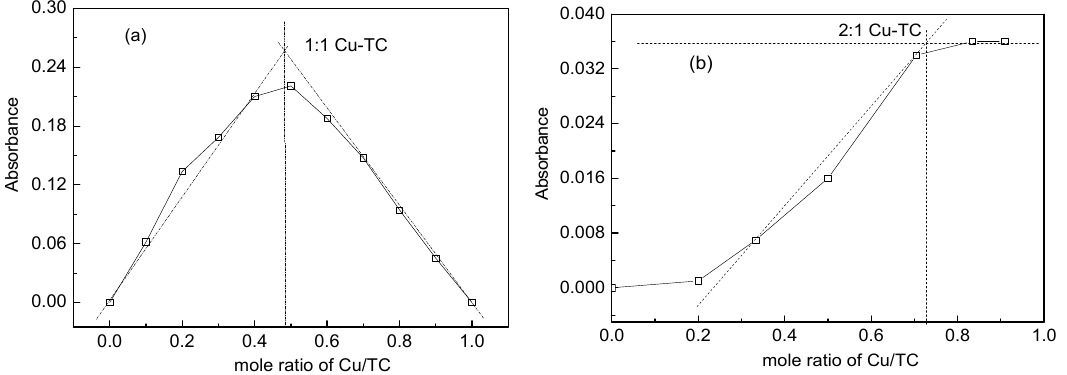
Figure 3. Complexation of Cu and TC: ( a ) 1:1 and ( b ) 2:1 complex at pH 6.0 by using Job’s method and Mole ratio method.